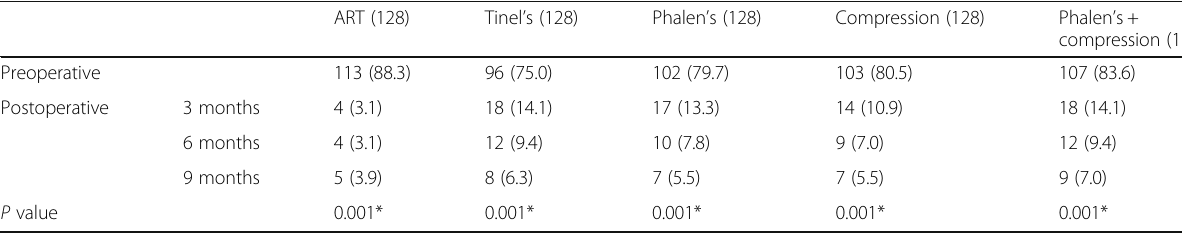
Table 3 Pre- and postoperative tests results among case group ART (128) Tinel ’ s